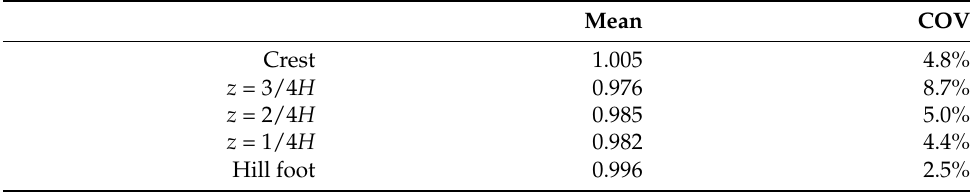
Figure 26. Experimental and predicted envelope values for horizontal wind velocity: ( a ) Crest, L = 0.5 D jet ; ( b ) Crest, L = 1.0 D jet ; ( c ) Hill foot, L = 0.5 D jet ; ( d ) Hill foot, L = 1.0 D jet . Table 7. Mean value and COV of γ U